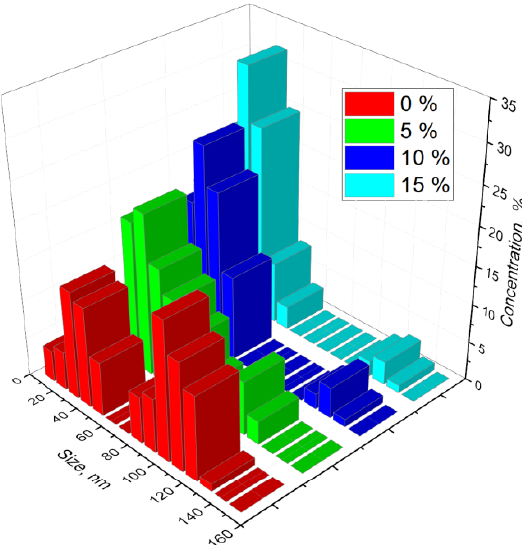
Figure 2. Size diagram obtained by analyzing grain sizes according to SEM image data.